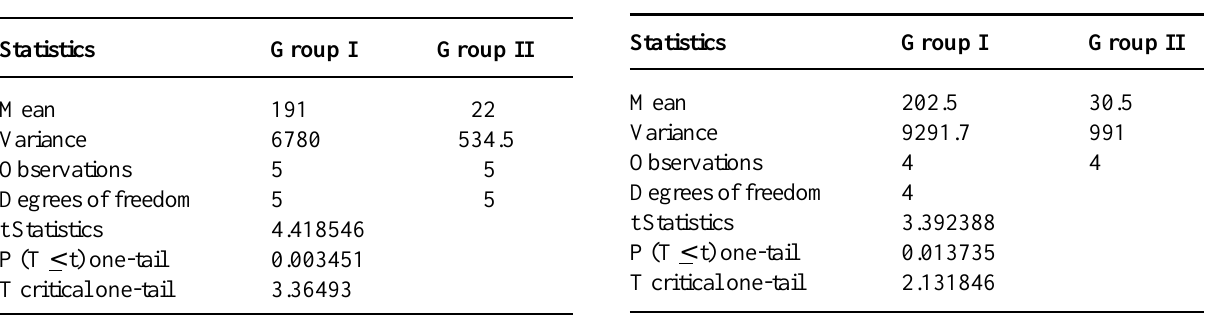
Table 2 – “t” test according to bladder capacity (mL) at 2 months.